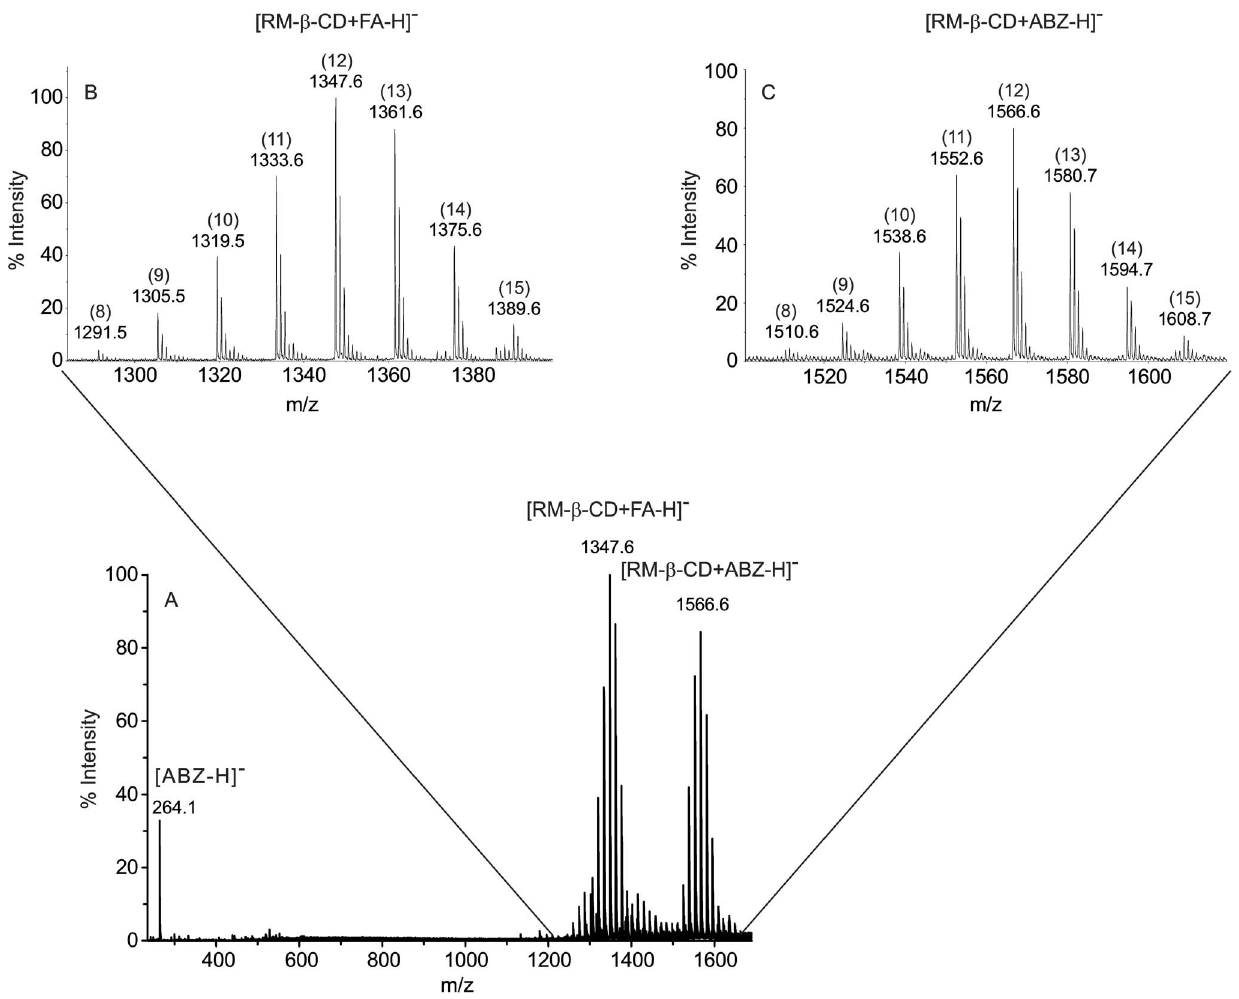
Figure 3. ESI-MS spectrum. A: Partial MS spectrum of ABZ:RM- b -CD obtained by spray drying dissolved in a formic acid solution. B and C: Zoom of regions corresponding to RM- b -CD and ABZ:RM- b -CD, respectively. The masses and the number of methyl substituents are written above each peak.